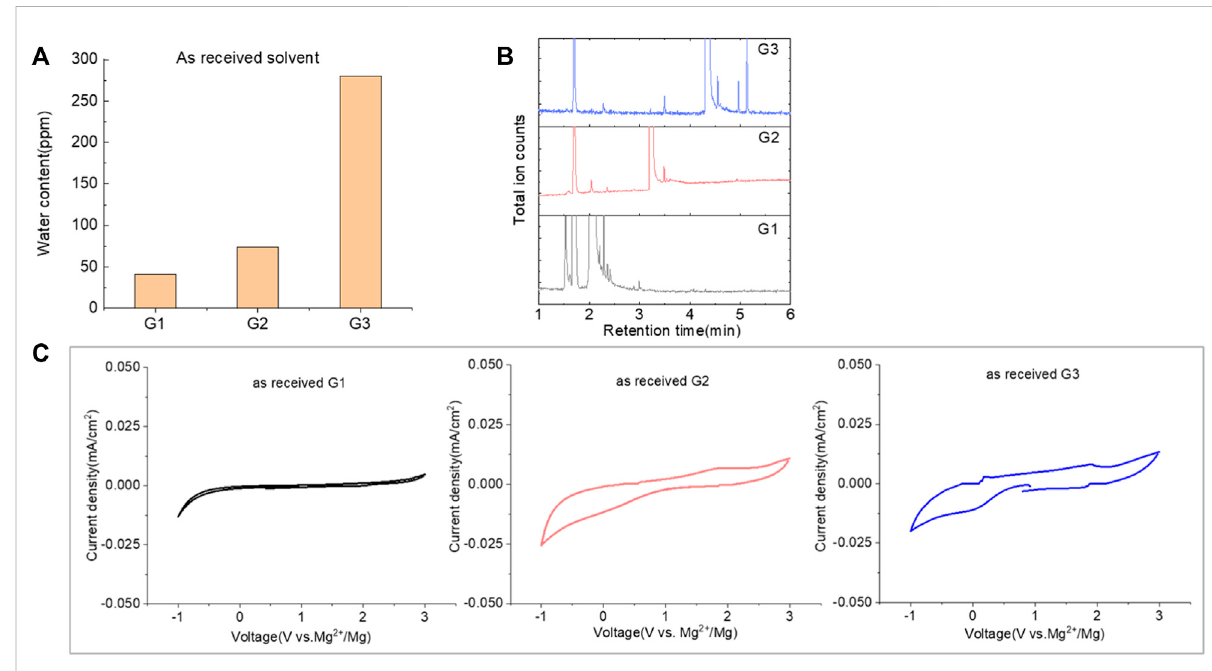
FIGURE 1 (A) Water content in the as-received solvents from G1 to G3 by Karl Fischer titration. (B) Chromatograms (total ion count) of the as-received solvents in G1, G2, and G3 by GC-MS. (C) Cyclic voltammogram of the freshly prepared electrolyte using “ as-received ” G1, G2, and G3 with 0.5 M MgTFIS 2 on a Pt electrode. Scan rate: 25